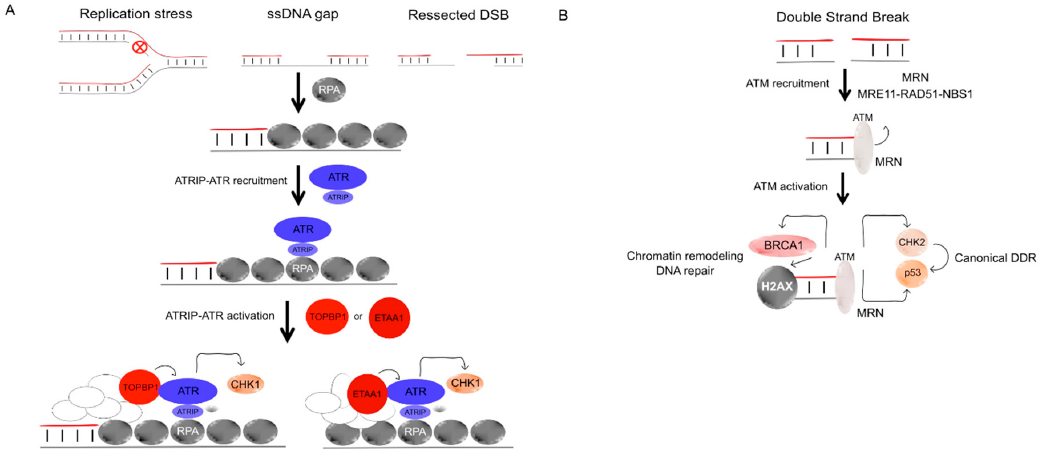
Figure 3. ATR-interacting protein-ataxia telangiectasia and Rad3 related (ATRIP-ATR) and ataxia telangiectasia-mutated (ATM) signalling. ( A ). Replication stress events (e.g., replication fork stalling), ssDNA gaps or resected DSB ends lead to the formation of ssDNA stretches. Replication Protein A (RPA) binds the ssDNA stretches and serve as a platform for ATRIP-ATR recruitment. Two modes of ATRIP-ATR activation have been described: in association with accessory proteins TOPBP1 or ETAA1 bind ATR triggering its autophosphorylation. Activated ATR, then, phosphorylate its downstream targets that include the protein kinase CHK1. ( B ) . The MRN (MRE11-RAD50-NBS1) complex recognize the DSB. ATM is recruited to the DSB site and binds the MRN complex, which leads to ATM activation. ATM then phosphorylates its downstream targets, including CHK2 and p53 during the canonical DNA damage response (DDR) and/or H2AX and BRCA1 for chromatin remodelling and DNA repair.